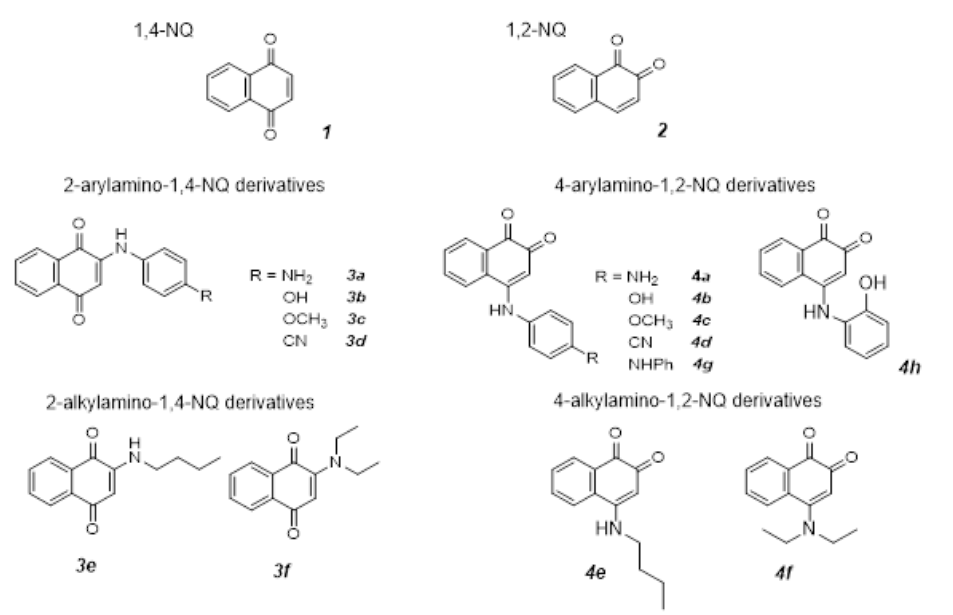
Figure 1. Structures of 1,4-NQ and 1,2-NQ and their derivatives.